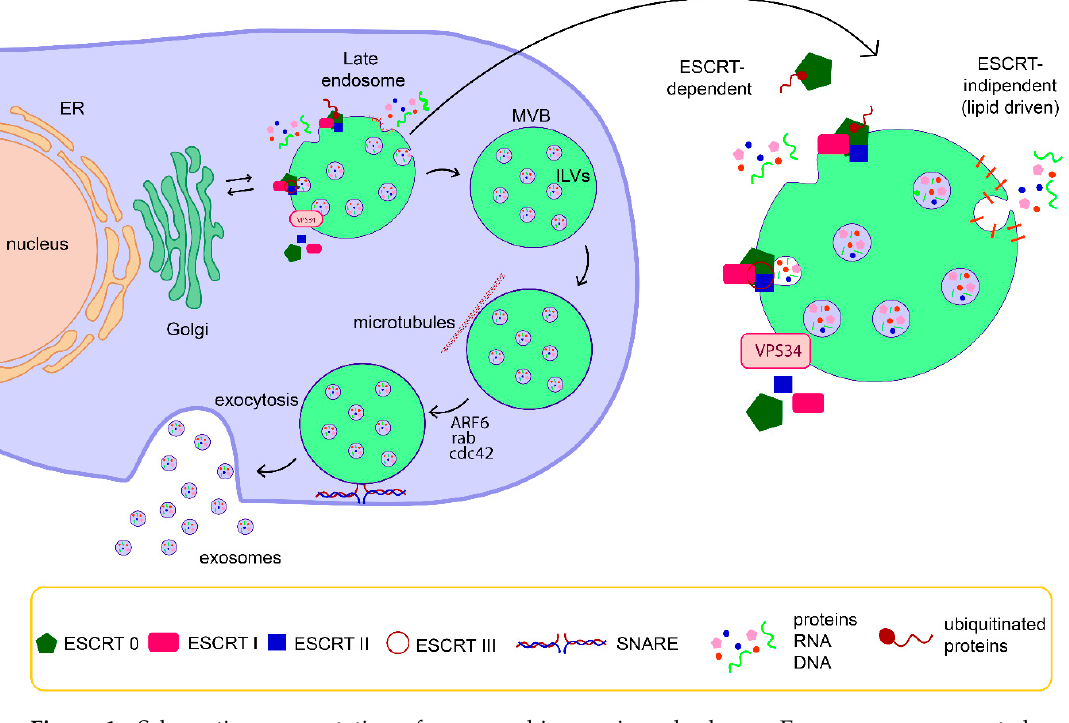
Figure 1. Schematic representation of exosome biogenesis and release. Exosomes are generated by invagination of late endosomal membranes that results in the formation of intraluminal vesicles (ILVs) within multivesicular bodies (MVBs). The formation of ILVs is driven by endosomal sorting complex required for transport (ESCRT) components and / or by specific membrane domains rich in lipids. Then, MVBs travel along microtubules and ILVs are ultimately secreted as exosomes through a SNARE-mediated fusion of MVBs with a plasma membrane.